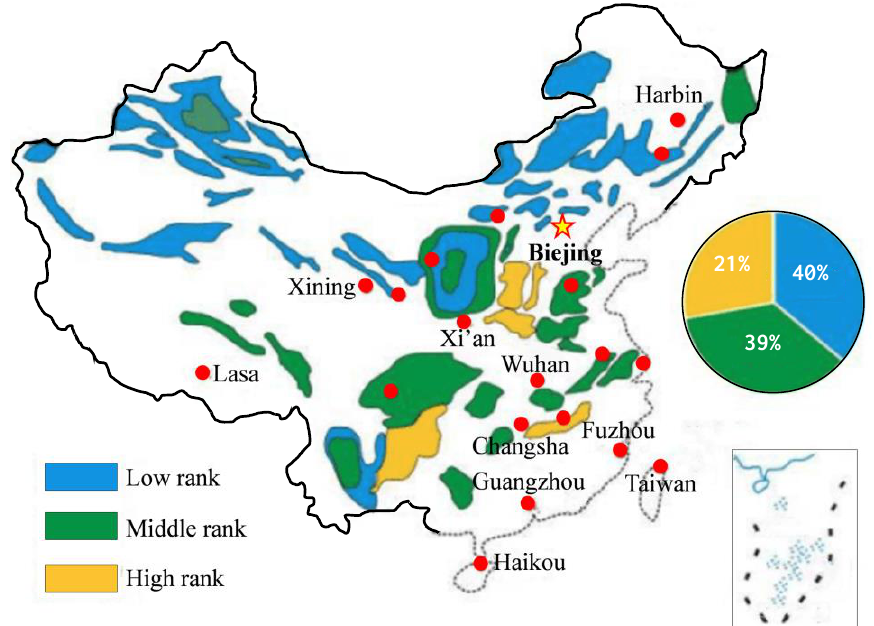
Figure 1. CBM resource distribution in China with a depth less than 2000 m. The vitrinite reflectance of a low-rank CBM reservoir is R o ≤ 0.7%, and those of middle-rank and high-rank reservoirs are 0.7% < R o < 1.9%, R o ≥ 1.9%, respectively (modified from Li et al., 2018) [4].